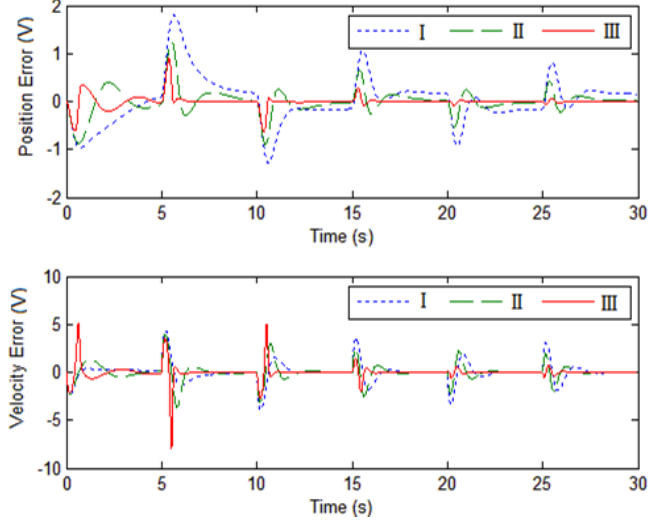
Figure 14. Comparison of experiment and simulation results (case I: experimental results of Adaptive control; case II: experimental results of adaptive control with integral action; and case III: Simulation results of simulation of adaptive control with integral